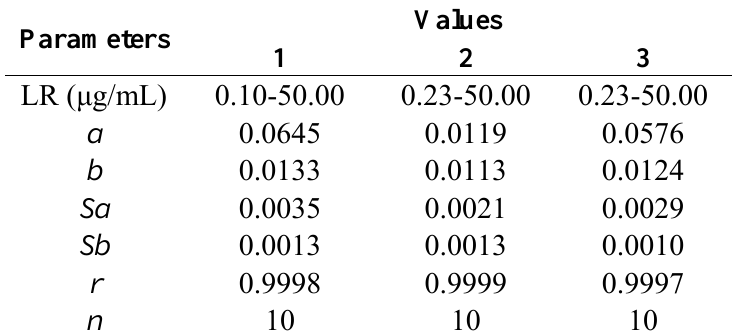
Table 1. Regression data of the analytical calibration curves for quantitative determination of the substances via